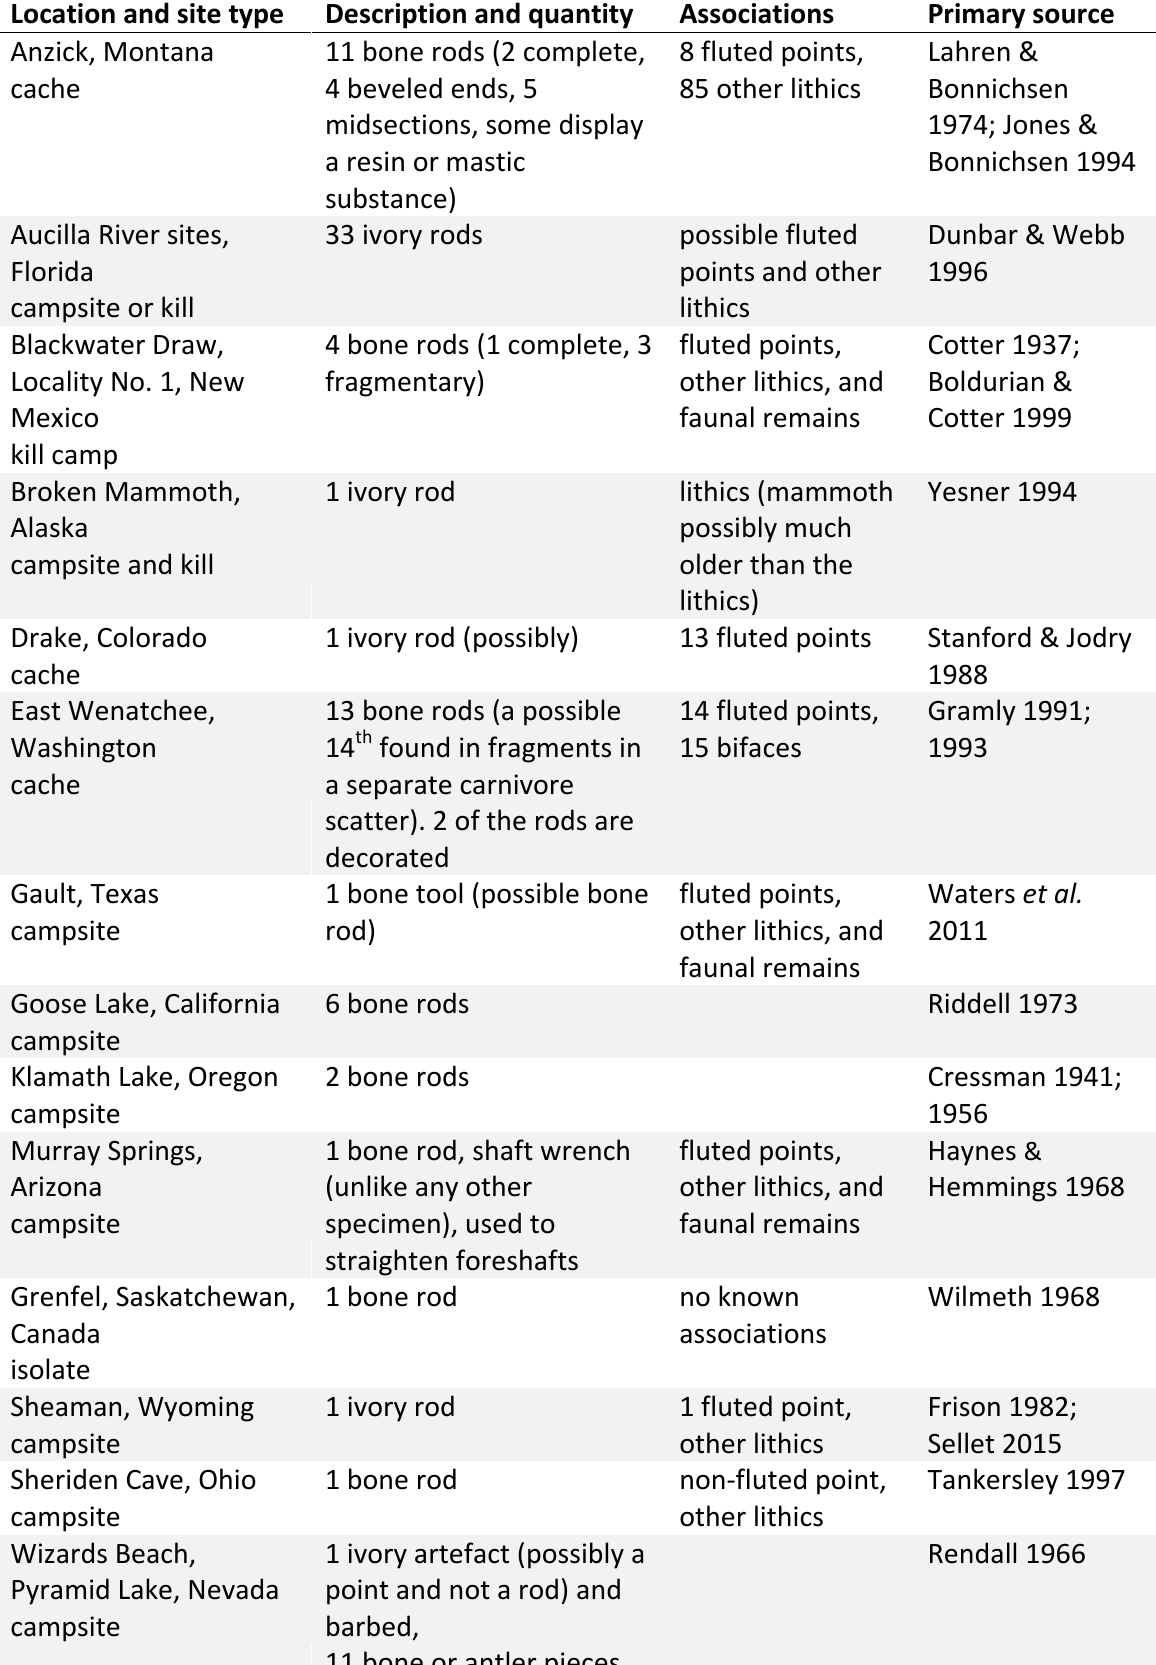
Table 1. Clovis or Clovis-era sites where bone or ivory rods have been found (after Haynes 2002). Location and site